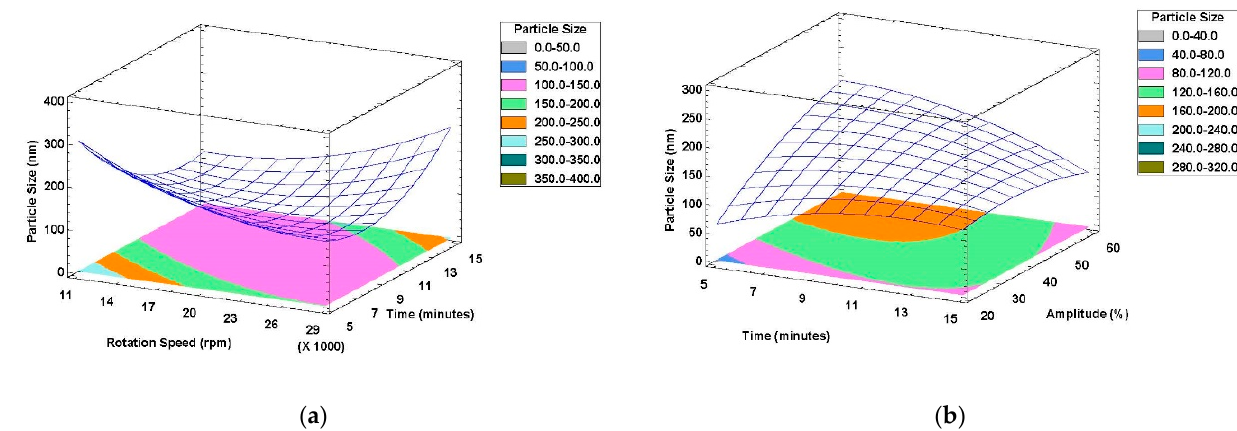
Figure 2. RSM plots of the effects of factors on particle size of W/O nanoemulsions: ( a ) rotor-stator mixer; ( b ) ultrasonic homogenizer.